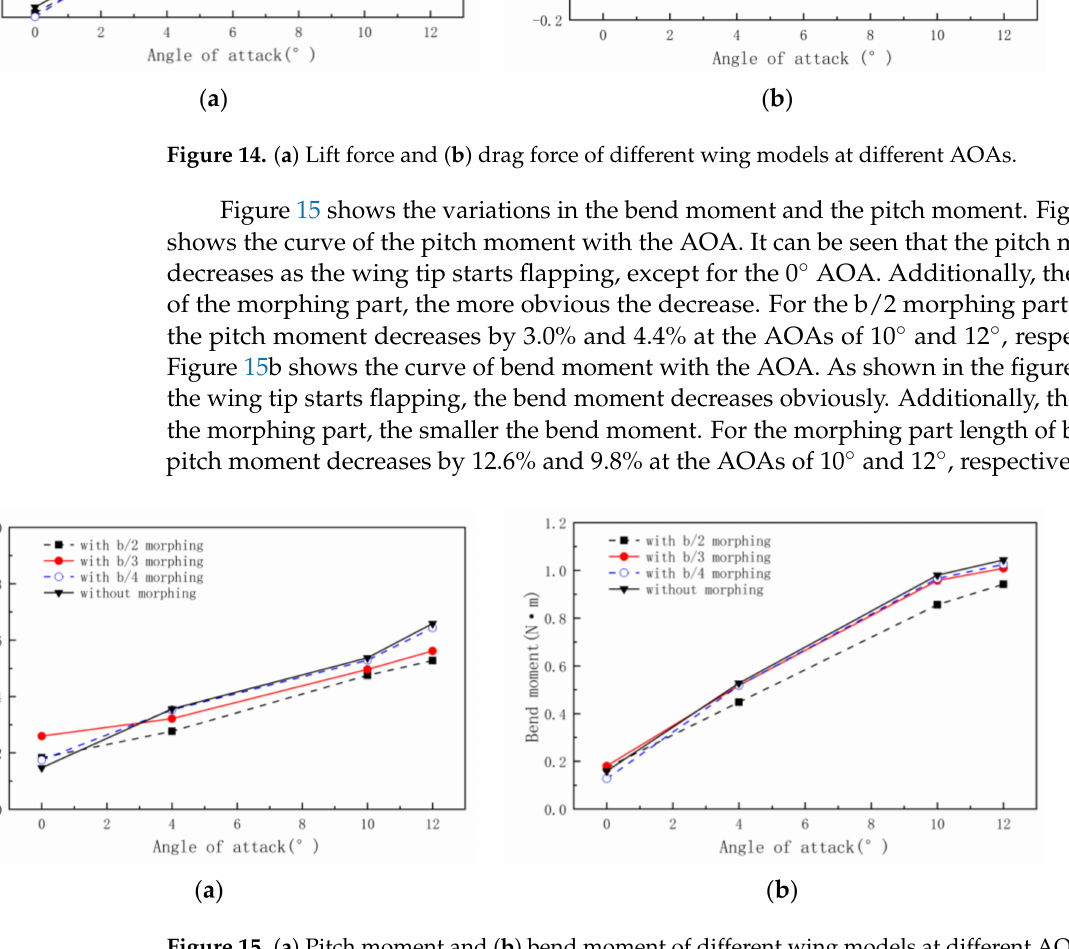
Figure 15. ( a ) Pitch moment and ( b ) bend moment of different wing models at different